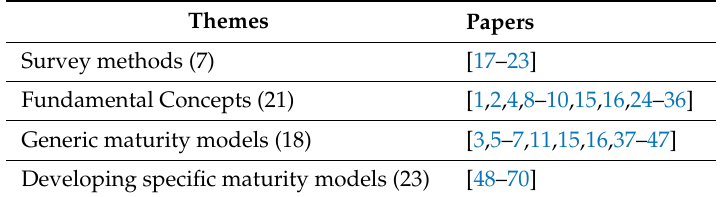
Table 1. Classification of the articles examined according to the themes under study in this work.